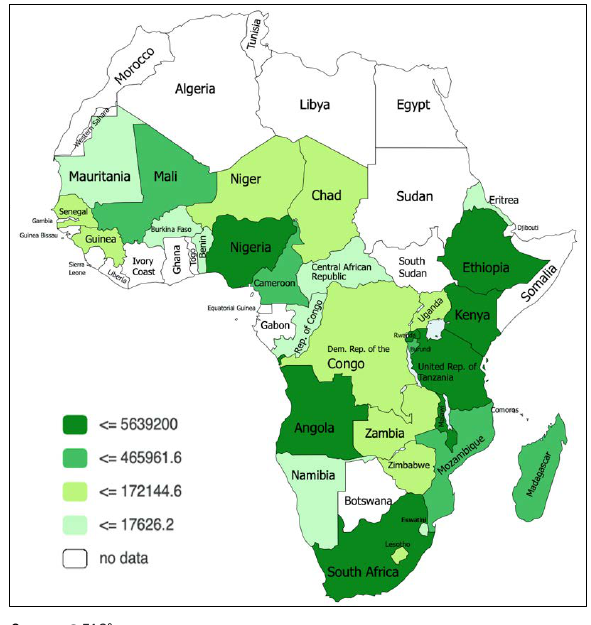
Figure 1: Potato production (in tonnes) in sub-Saharan Africa (mean 2014–2018).